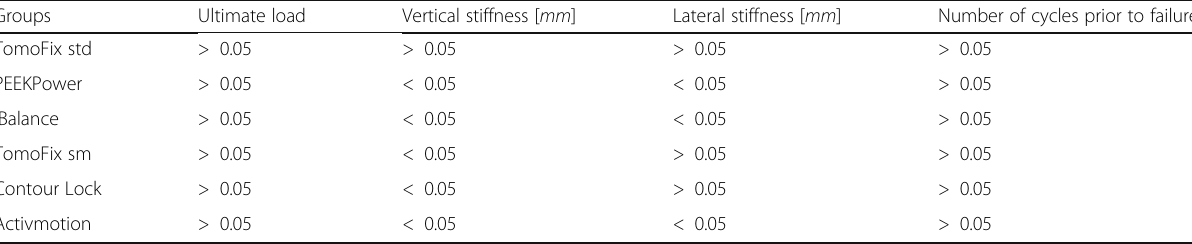
Table 9 p -Values obtained from the t-tests comparing the FlexitSystem to the previously tested implants Groups